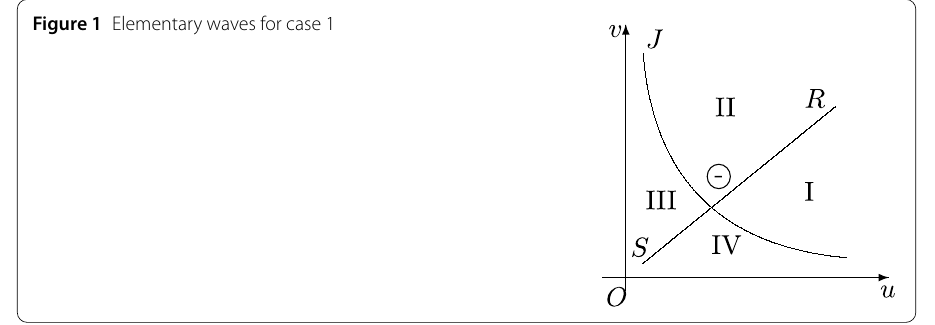
Figure 1 Elementary waves for case